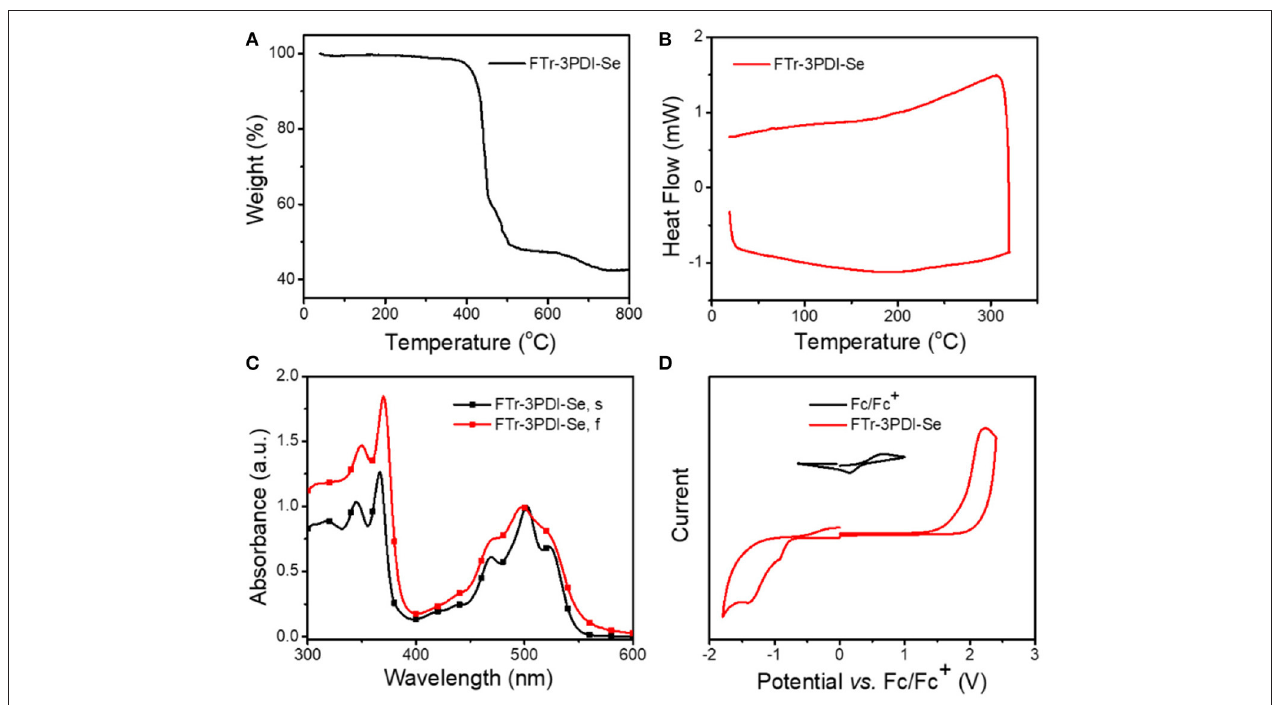
FIGURE 2 | (A) TGA of FTr-3PDI-Se; (B) DSC of FTr-3PDI-Se; (C) normalized UV–vis absorption spectra of FTr-3PDI-Se in CHCl 3 solution (FTr-3PDI-Se, s) and in film (FTr-3PDI-Se, f); (D) CV curves of